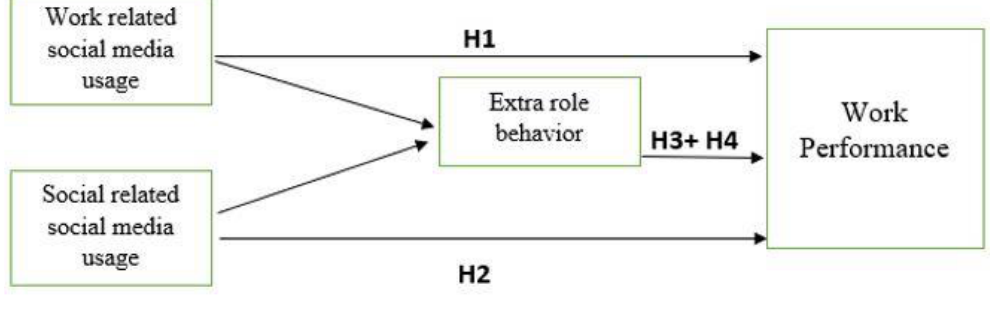
Figure 1. Conceptual Framework of the